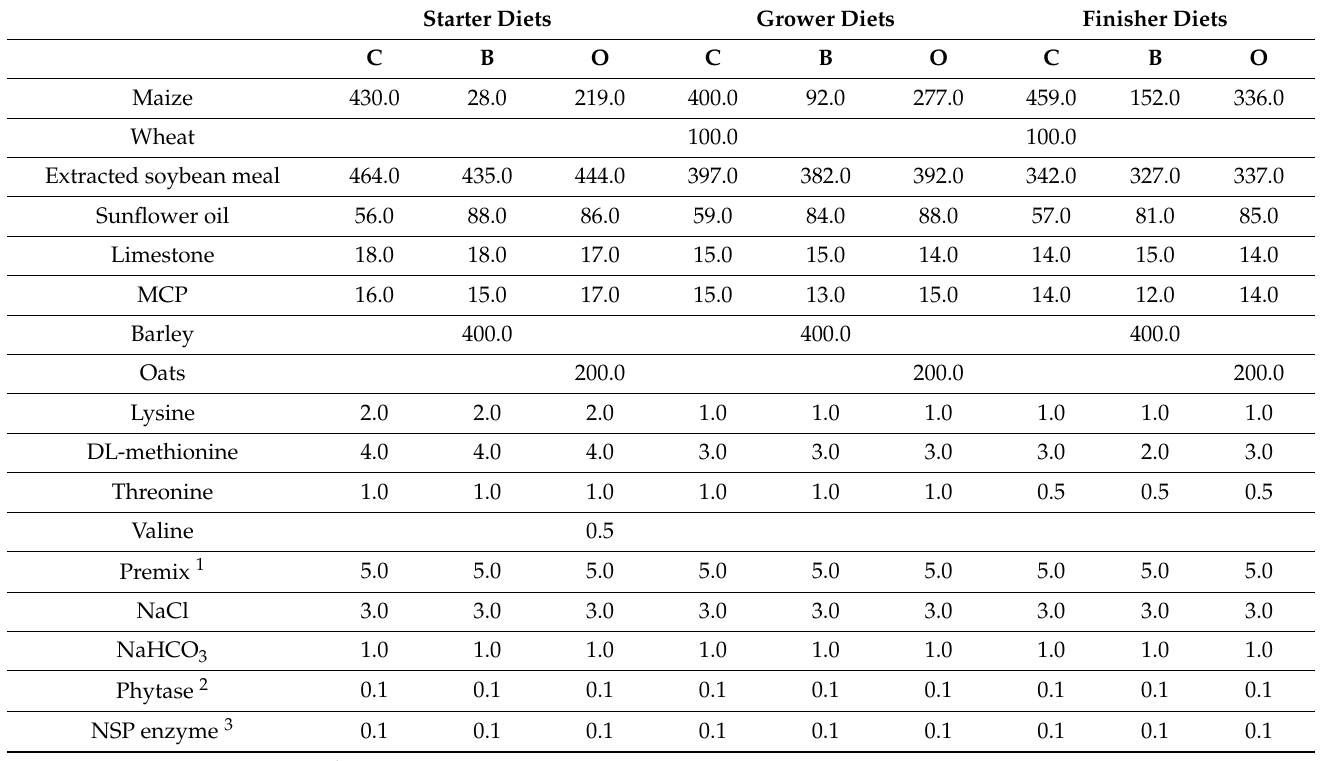
Table 2. Composition of experimental diets (g/kg as